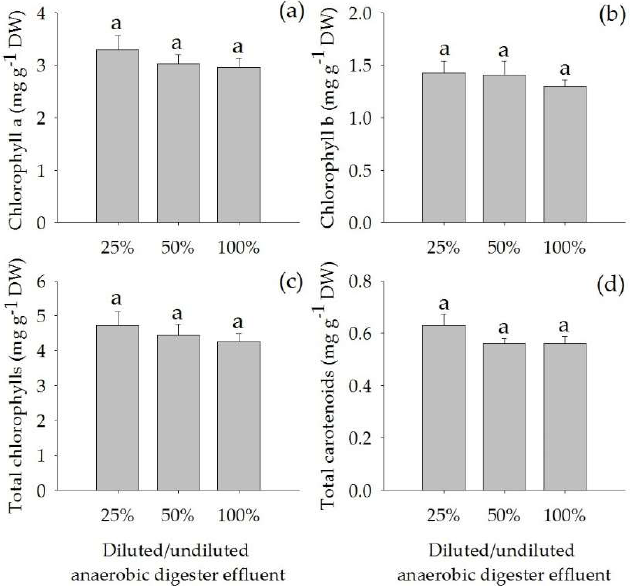
Figure 3. Concentrations of chlorophyll a ( a ), chlorophyll b ( b ), total chlorophylls ( c ) and total carotenoids ( d ) (Mean ± SE) in leaves of Acorus calamus grown on diluted anaerobic digester effluent (25% and 50%) and undiluted anaerobic digester effluent (100%) for a period of 56 days.